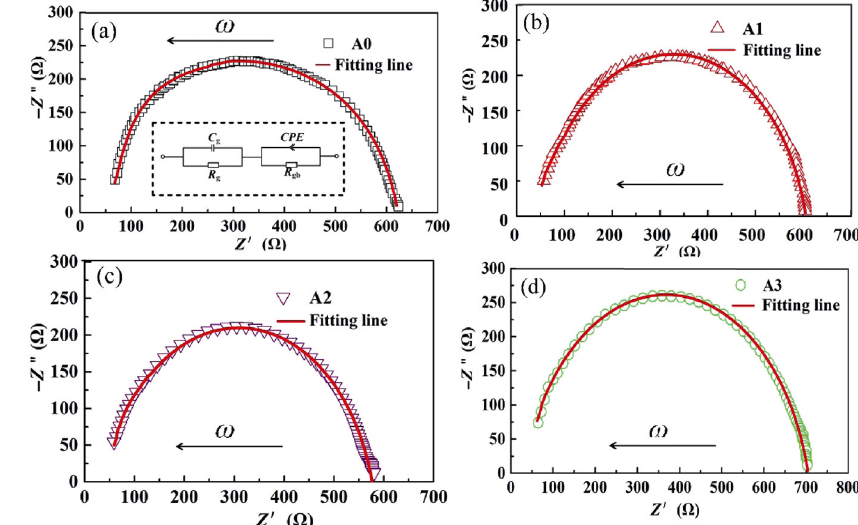
Fig. 11 Impedance spectroscopies of MCNS ceramics: (a) A0 (with the equivalent circuit for fitting the impedance data in the inset), (b) A1, (c) A2, and (d) A3 ceramics at